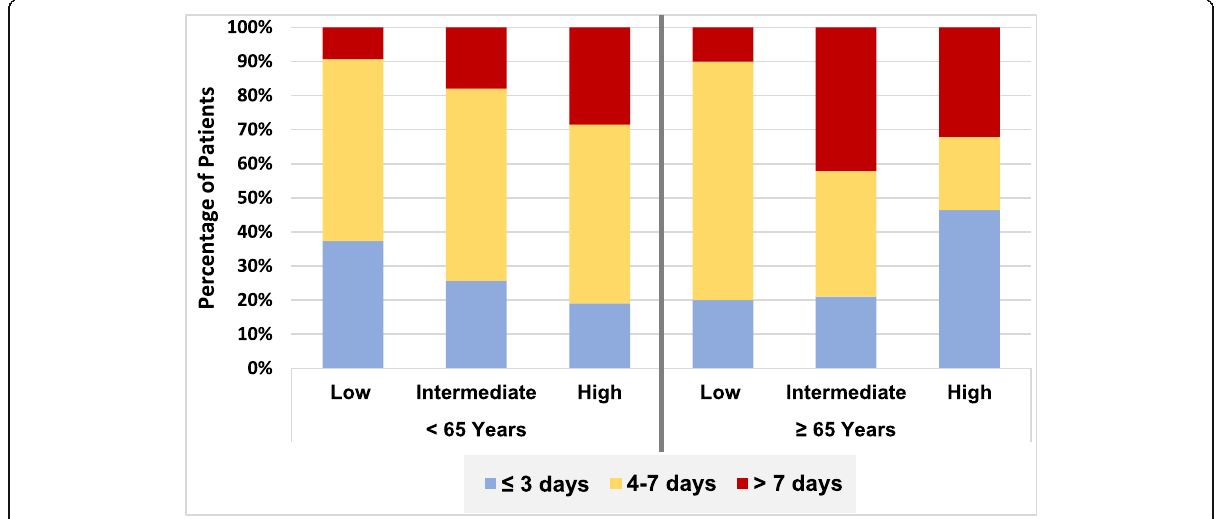
Fig. 6 Hospitalization duration in NSTE-ACS according to age and GRACE risk class. Comparing hospitalization duration between the two age categories according to risk class p value = 0.3 (low-risk class), 0.6 (intermediate-risk class) and 0.51 (high-risk